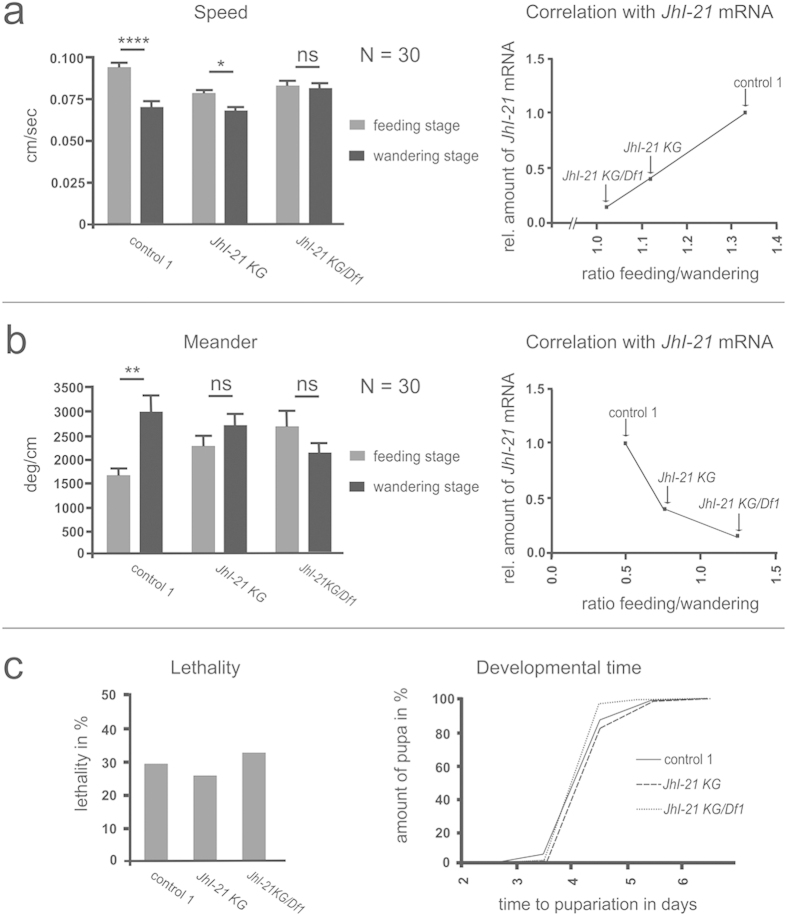
JhI-21 mutants lack age-dependent shift in locomotor behaviors.(a,b) Parameters of locomotion were analyzed in wildtype larvae (control 1, w1118) and JhI-21 mutants (JhI-21 KG and JhI-21 KG/Df1). (a) right, Speed is significantly decreased in wandering wildtype larvae compared to feeding individuals. ****p < 0.0001. This difference is still present, although reduced in JhI-21 KG mutants. *p < 0.05. Difference in speed between feeding and wandering larvae is not present in JhI-21 KG/Df1 mutants. Left, the ratio of average speed of feeding larvae/average speed of wandering larvae correlates with JhI-21 mRNA levels. (b) right, the meander describes amount of turnings in degree per cm and was used to characterize the turning behavior. 3rd instar wildtype larvae increase their average turning in wandering stage. **p < 0.01. Neither JhI-21 KG nor JhI-21 KG/Df1 mutants show a significant change in turning behavior between both 3rd-instar larval stages. Left, the ratio of average meander of feeding larvae/average speed of wandering larvae shows negative correlation with JhI-21 mRNA levels. (c) JhI-21 mutants show no difference in lethality or developmental time as compared to the control genotype. Statistical test in (a,b): 2-Way-ANOVA, N = 30, Error bars represent SEM. Statistical test in c Mantel-Cox test: N = 131-334 per genotype.